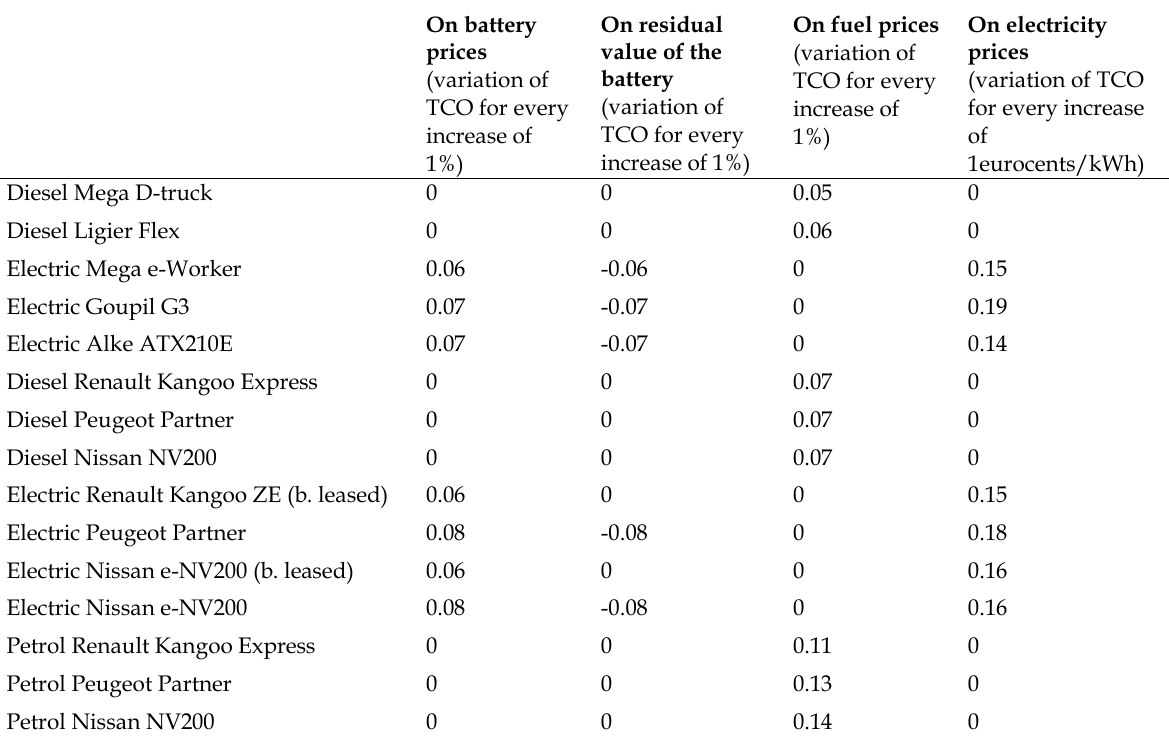
Table 2. Sensitivity analysis of TCO results on battery prices, fuel prices and residual value of the